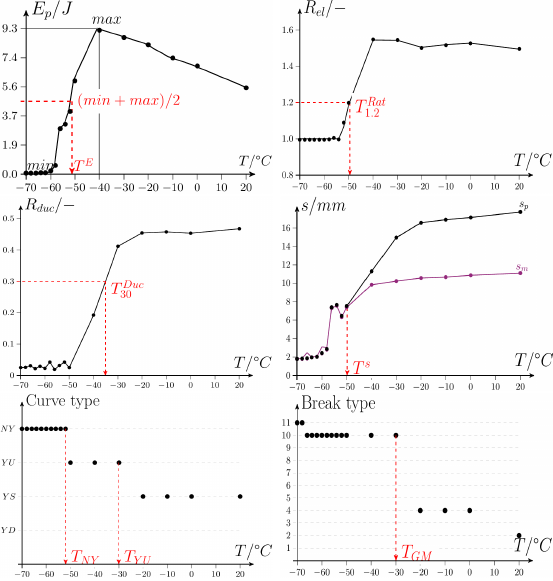
Figure 5. Determination of transition